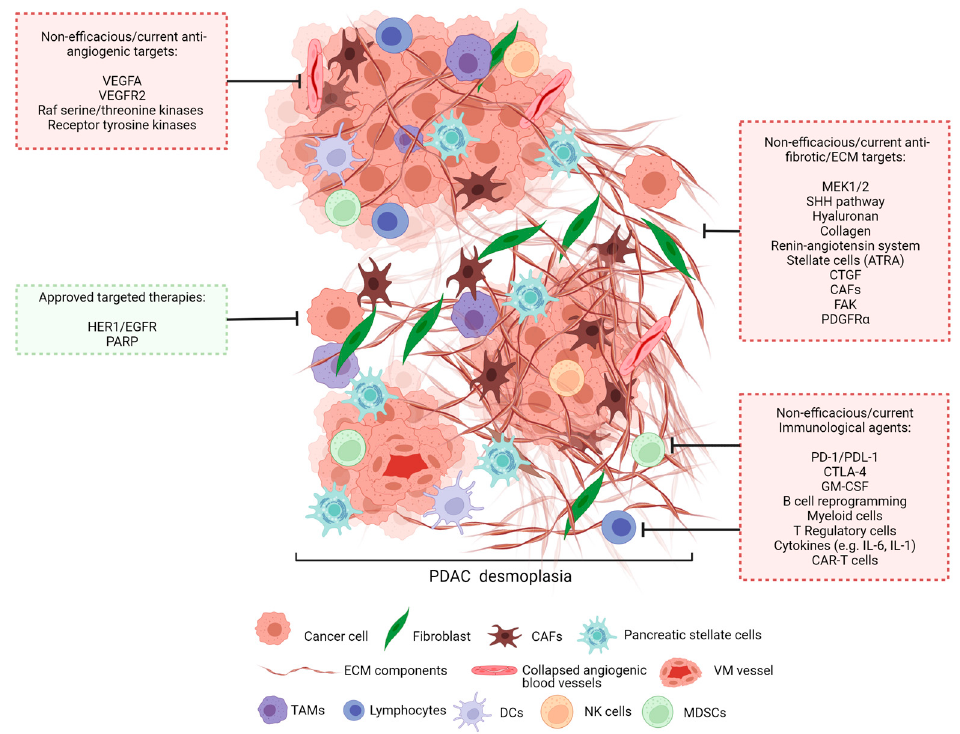
Figure 2. PDAC tumour microenvironment and therapeutic targets. A key feature of PDAC is the presence of dense fibrotic stroma or desmoplasia. PDAC tumours consist of ECM components such as collagen and hyaluronan, as well as pro-tumourigenic and anti-tumorigenic cellular components such as fibroblasts, vessel forming endothelial cells, vasculogenic mimicry (VM) vessels, cancer associated fibroblasts (CAFs), pancreatic stellate cells, lymphocytes, dendritic cells (DCs), tumour associated macrophages (TAMs), natural killer (NK) cells, and myeloid derived suppressor cells (MDSCs).